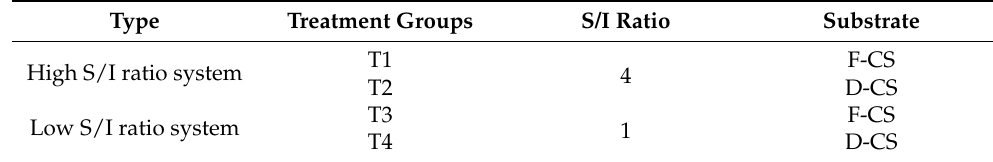
Table 1. Experimental design